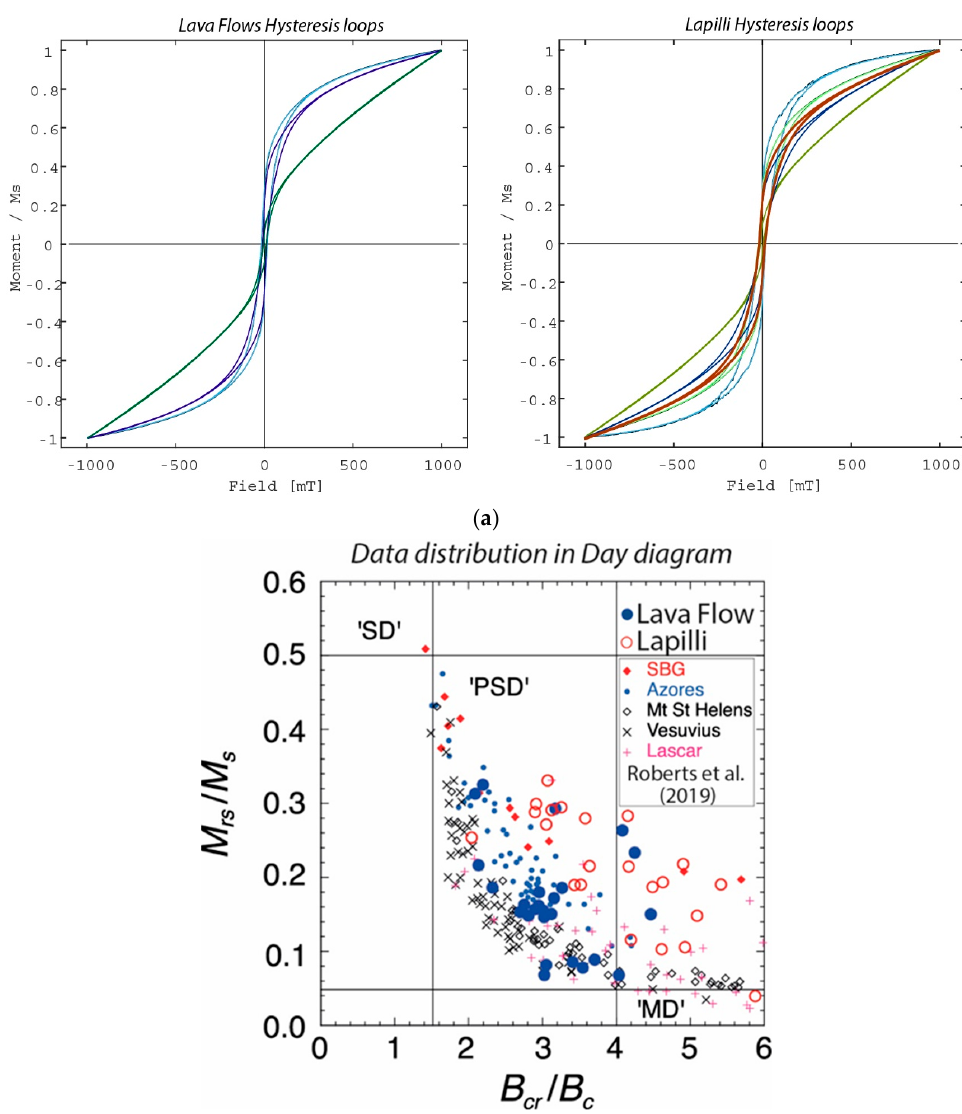
Figure 8. ( a ) Hysteresis loops for representative samples and ( b ) Day diagram for different basaltic rocks (modified from [40]). See text for discussion.